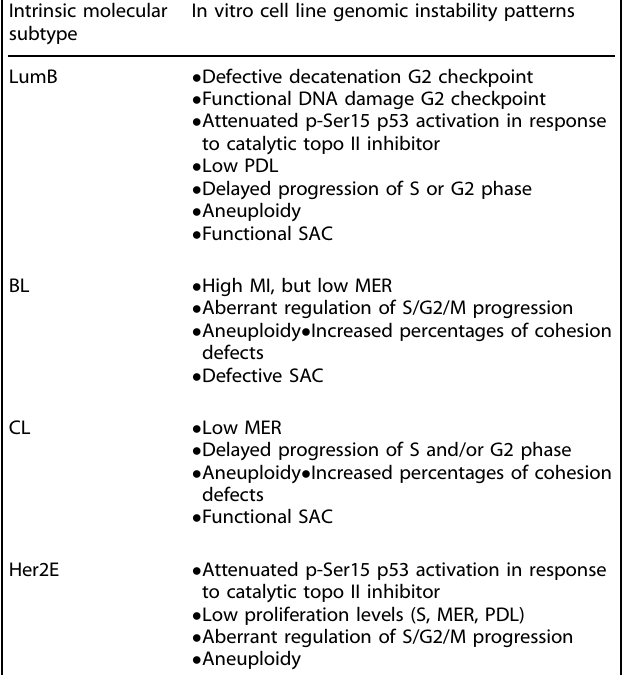
Table 2. Summary of subtype associated genomic instability